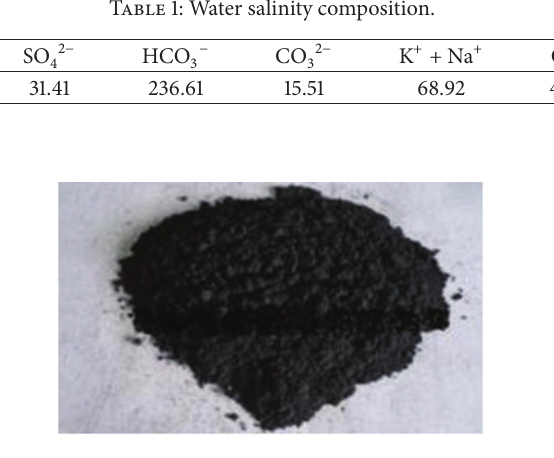
Figure 3: Asphalt particles of different grain sizes.